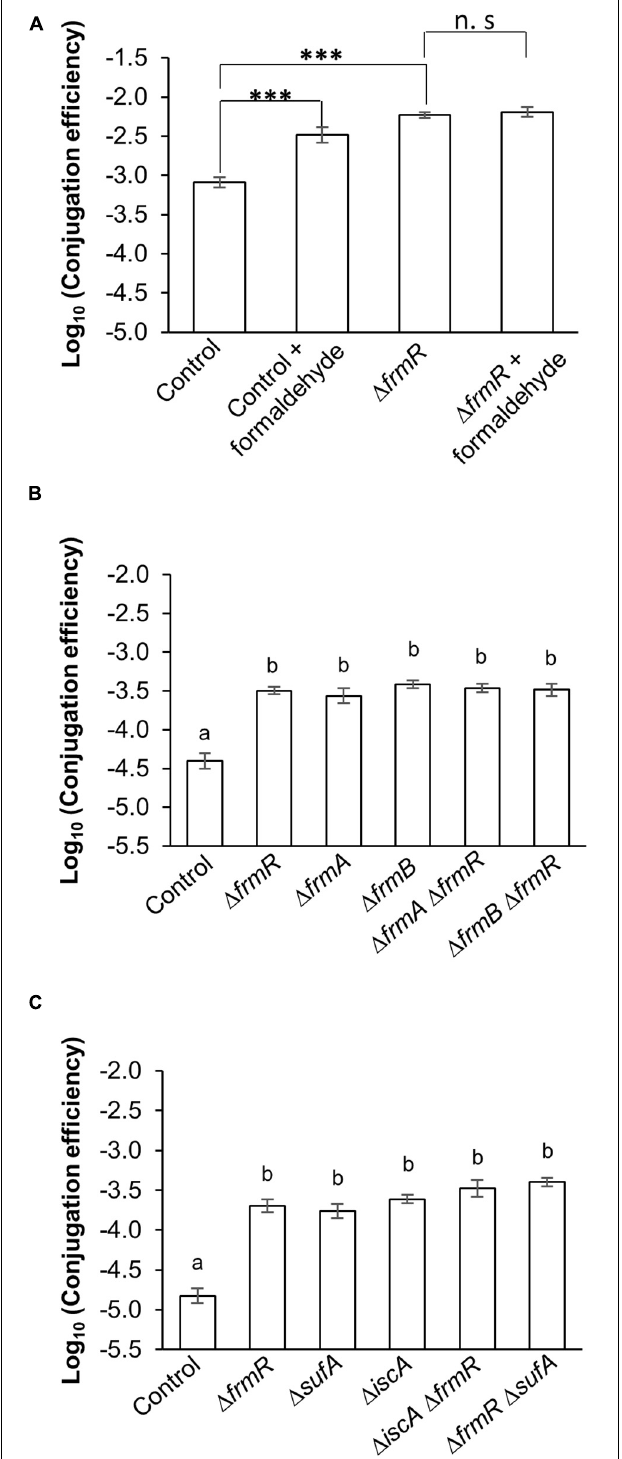
FIGURE 2 | Confirmation analysis of the high conjugation efficiency in frmR , sufA , and iscA mutants. (A) Effect of formaldehyde (250 µ M) on the conjugation efficiency of IncP1 α plasmid transfer by (cid:49) frmR mutants and wild-type control to E. coli recipient within five experimental replicates ( n = 5).